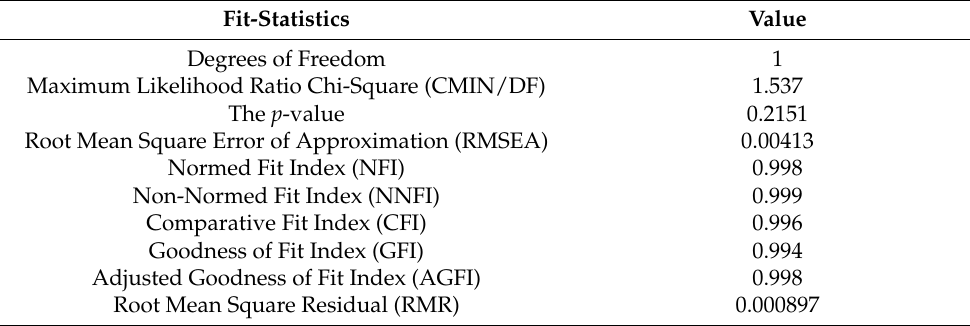
Table 4. Path model goodness-of-fit statistics. Fit-Statistics